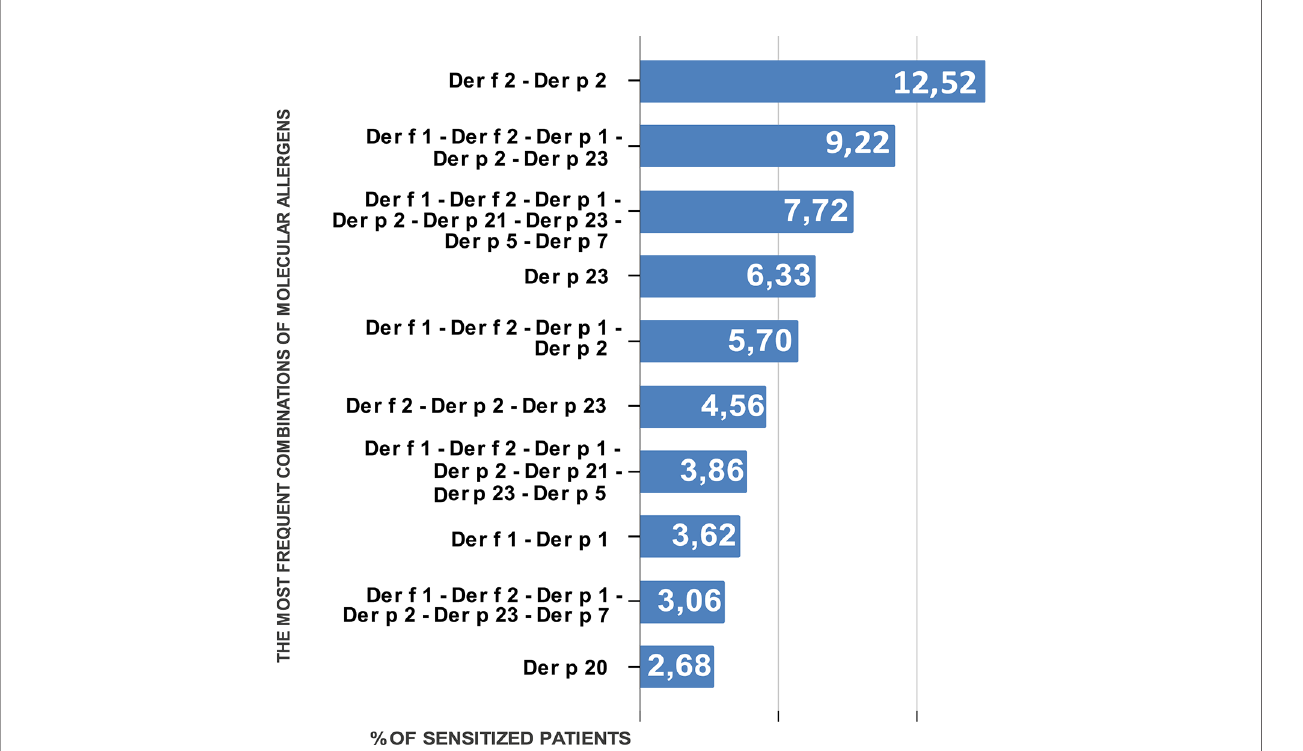
FIGURE 2 | Percentage of people sensitized to different combinations of molecular allergens of